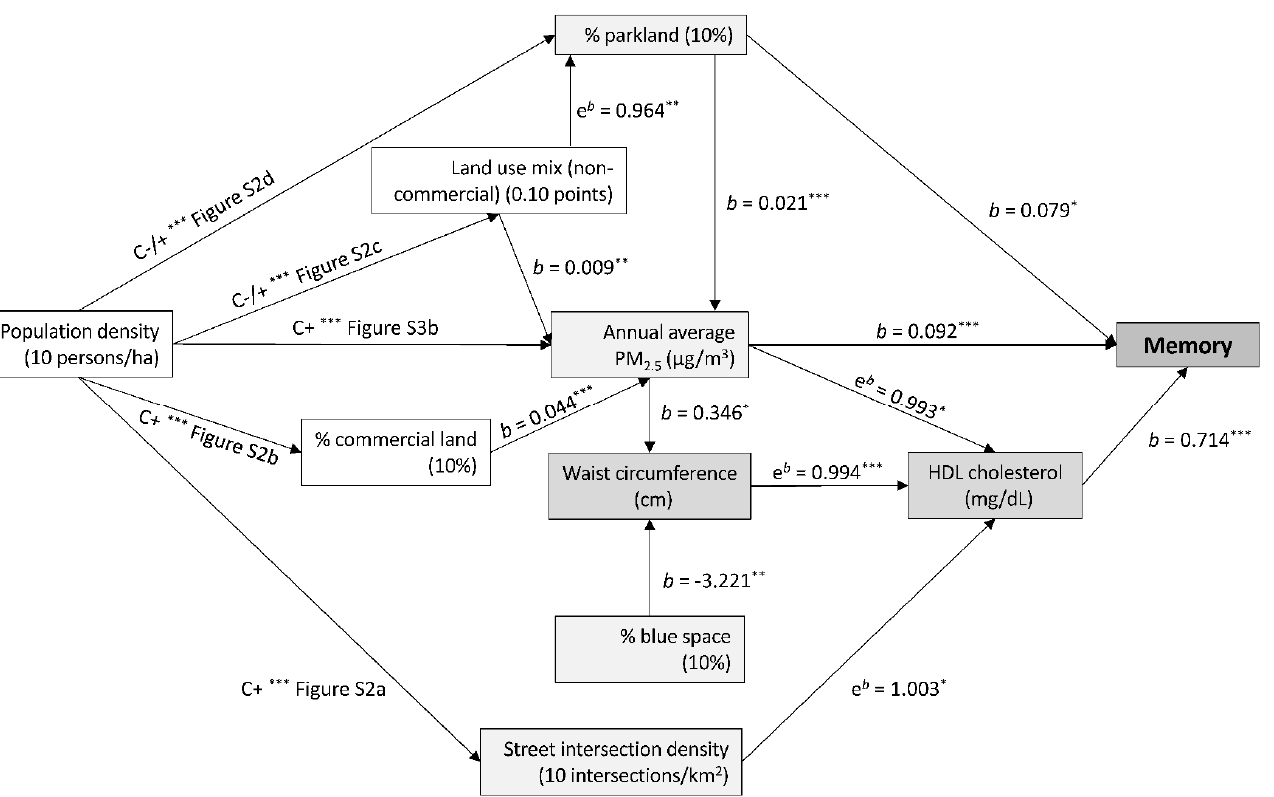
Figure 2. Effects of neighbourhood environmental characteristics on memory and the mediation roles of cardiovascular risk factors. Arrows linking variables indicate significant associations; b , regression coefficient; e b , exponentiated regression coefficient; ha, hectare; C+, −, +/− = curvilinear positive, negative, non-monotonic association; Figure Sx; the supplementary figure of a curvilinear association. * p < 0.05; ** p < 0.01; *** p < 0.001. Cardiometabolic risk factors are represented by darker grey rectangles; environmental characteristics directly associated with memory or cardiometabolic risk factors are represented by light grey rectangles; environmental attributes indirectly associated with cardiometabolic risk factors through other environmental characteristics are represented by white rectangles. All significant and non-significant associations (regression coefficients and 95% CIs) are presented in the Supplementary Materials (Tables S2–S4). Table S2 also provides the F-ratio of the smooth terms for significant curvilinear associations.